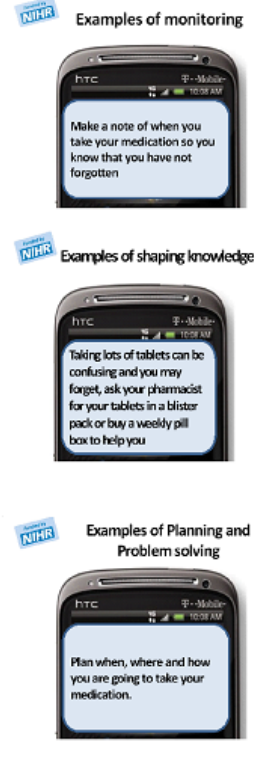
Figure 1. Examples of messages from the Support Through Mobile Messaging and Digital Health Technology for Diabetes